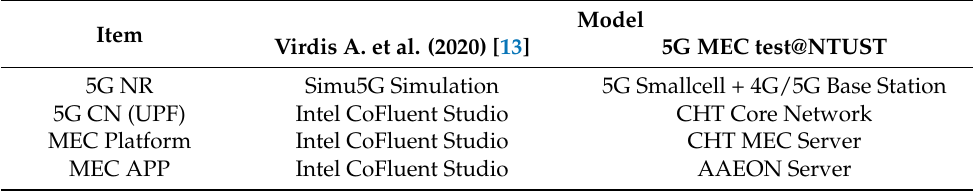
Table 1. 5G MEC Model—simulation model (Virdis) and experiment model (NTUST). Item